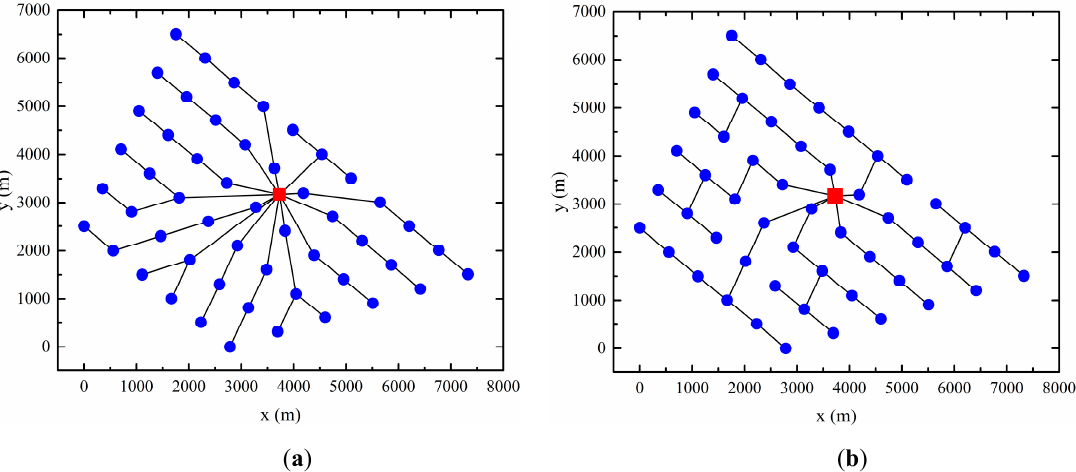
Figure 11. Optimized topology for the Walney 1 wind farm by ( a ) the integration method and ( b ) the two-step method.